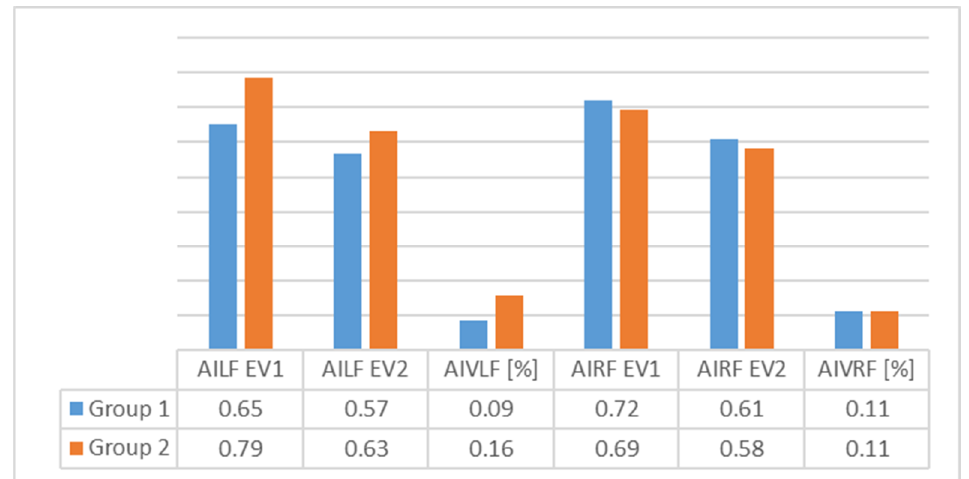
Figure 8. Average values for plantar index arch—comparison between the two groups (AILF = plantar index arch for left foot; AIVLF = plantar index arch variation for left foot; AIRF = plantar index arch for right foot; AIVRF = plantar index arch variation for right foot).